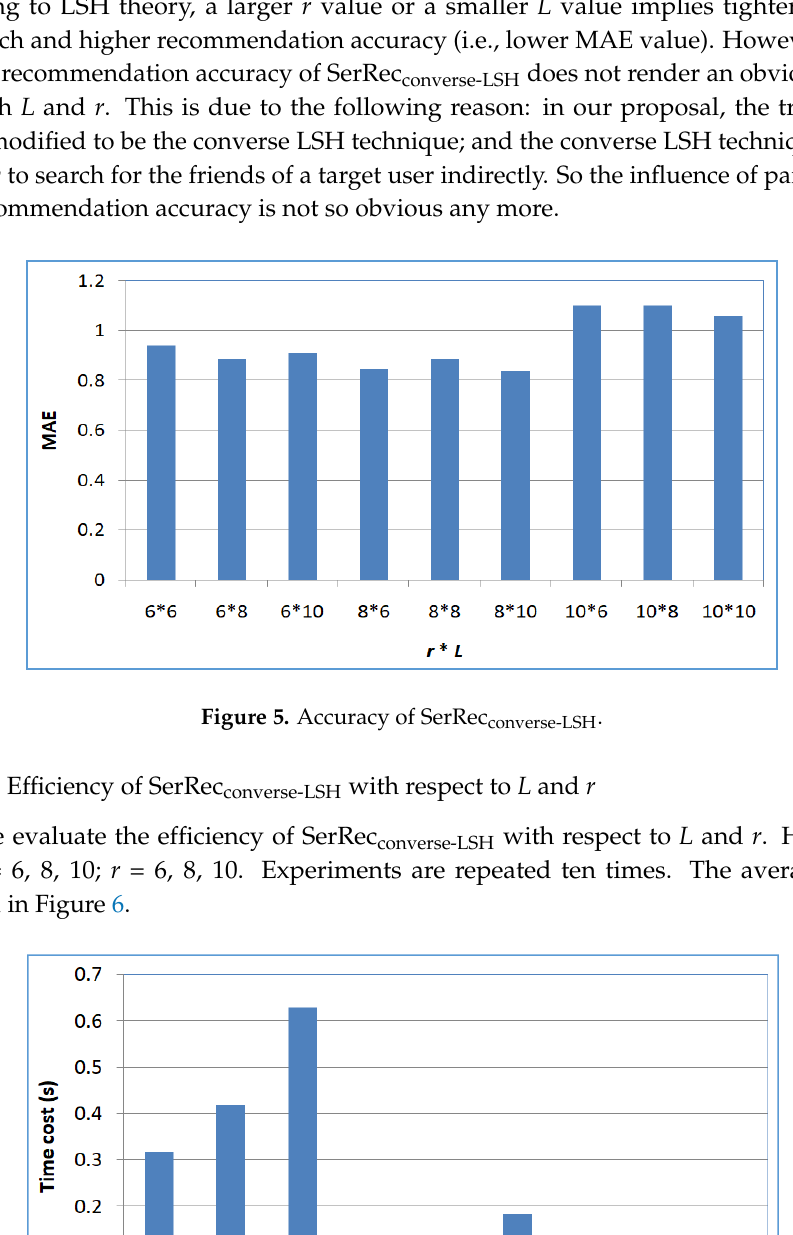
Figure 6. Efficiency of SerRec converse-LSH .